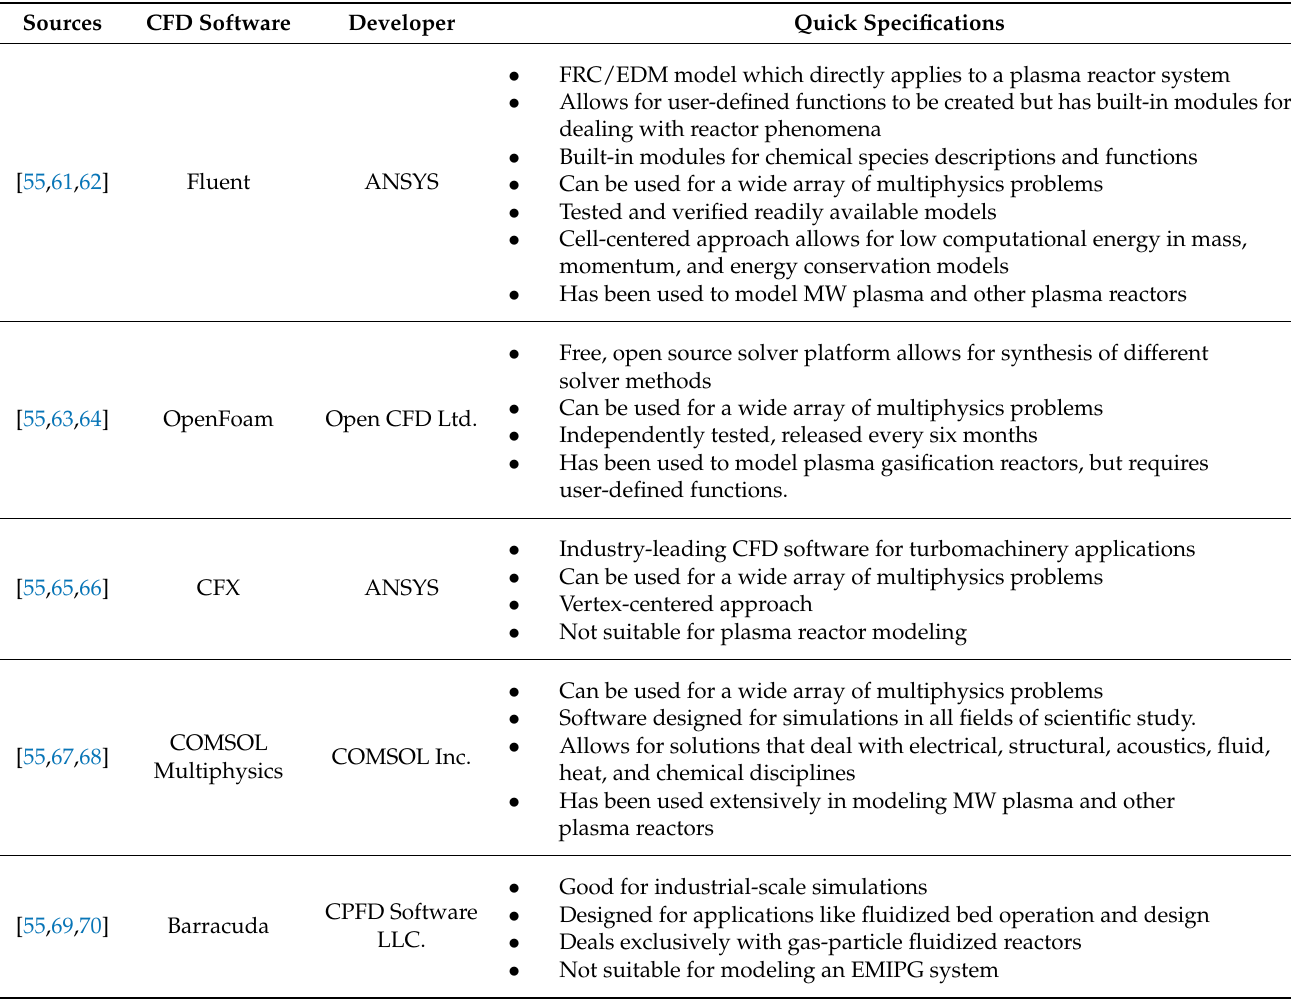
Table 9. Comparison of CFD modeling software